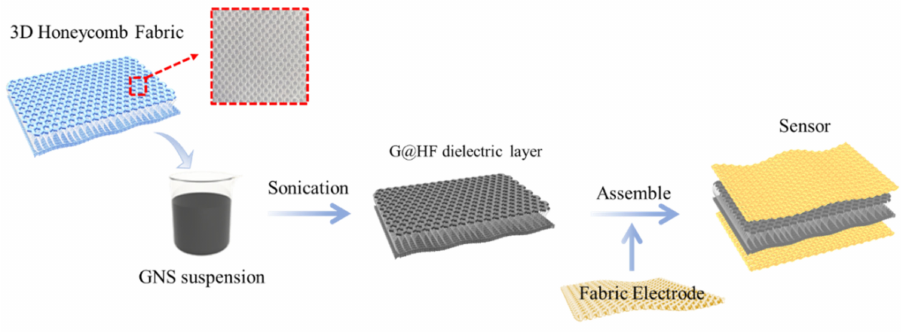
Figure 1. Schematical illustration of the preparation procedure for the BAFC